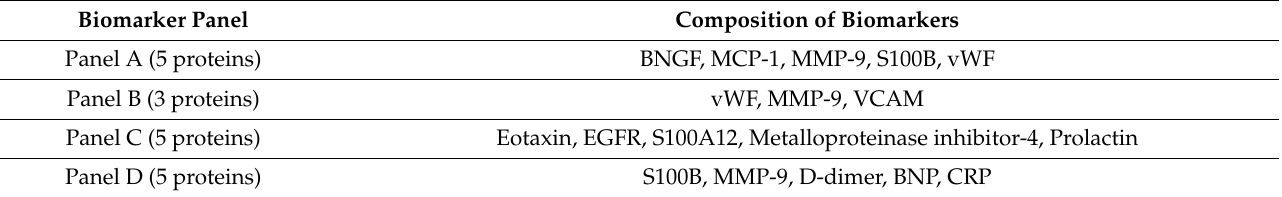
Table 3. Panel biomarker